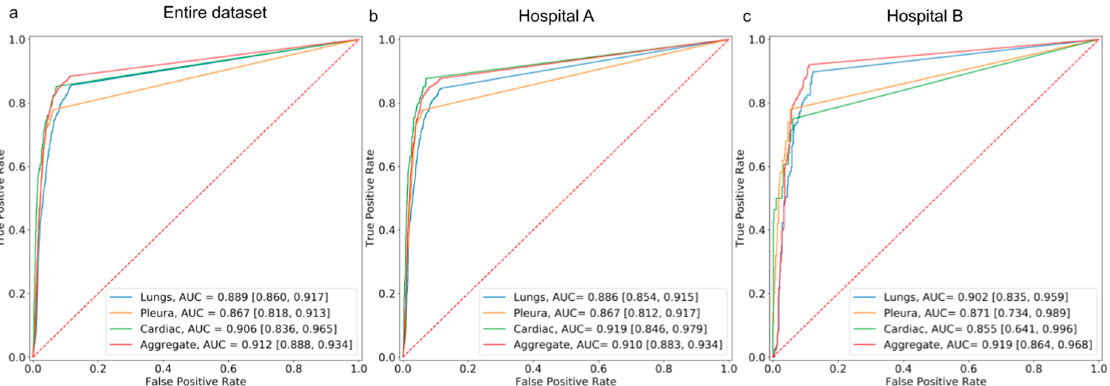
Figure 3. AUROC curves depicting the performance of the standalone AI model in detecting suspicious ROIs in the lungs, cardiac, and pleura categories on ( a ) the entire hospital dataset, ( b ) the dataset from Hospital A, and ( c ) the dataset from Hospital B.